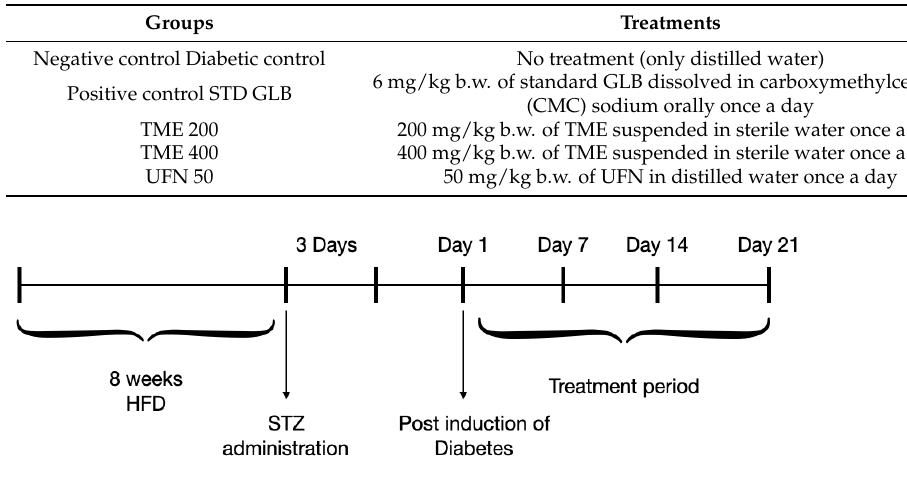
Figure 8. Schematic diagram for the induction of DM and treatment procedures in the experimental animals. Table 3. Groups and their respective treatments.